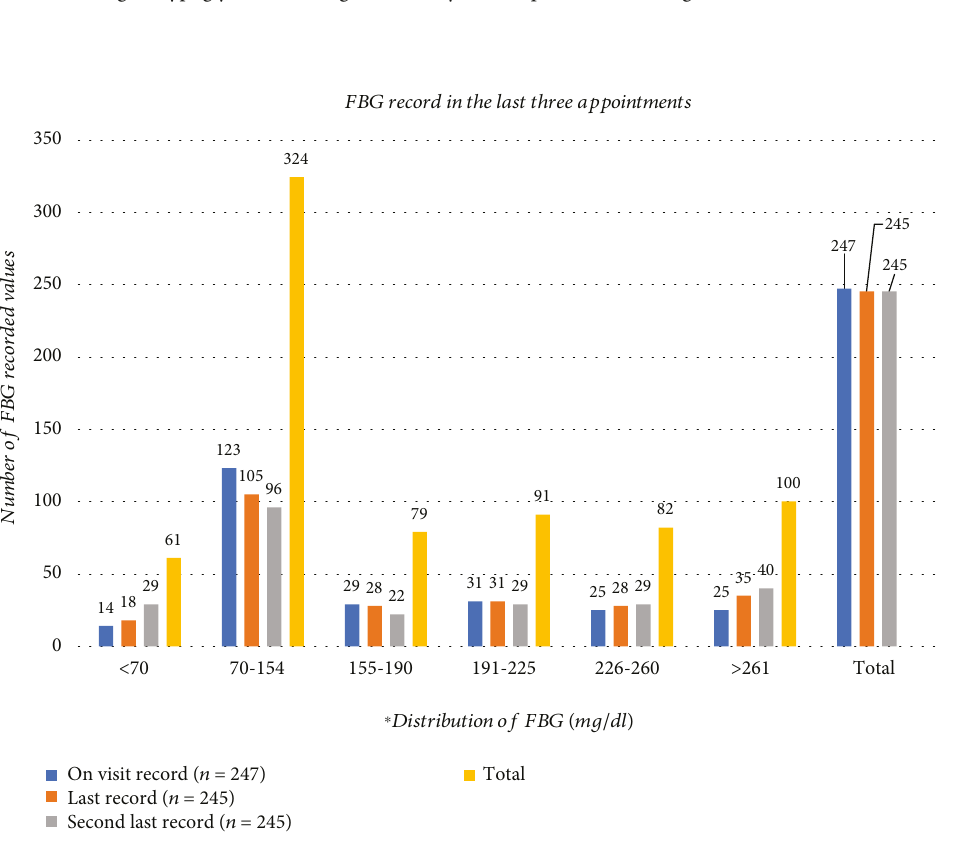
Figure 1: Reasons contributing to hypoglycemia among ambulatory T1DM patients attending at SPHMMC in June 01 to August 01, 2018.